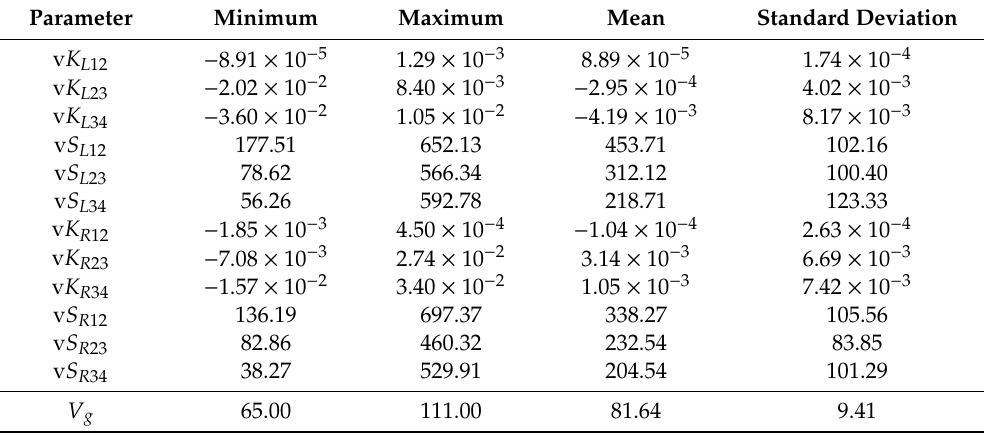
Table 2. Distribution of shape parameters and geometry-determined speed.